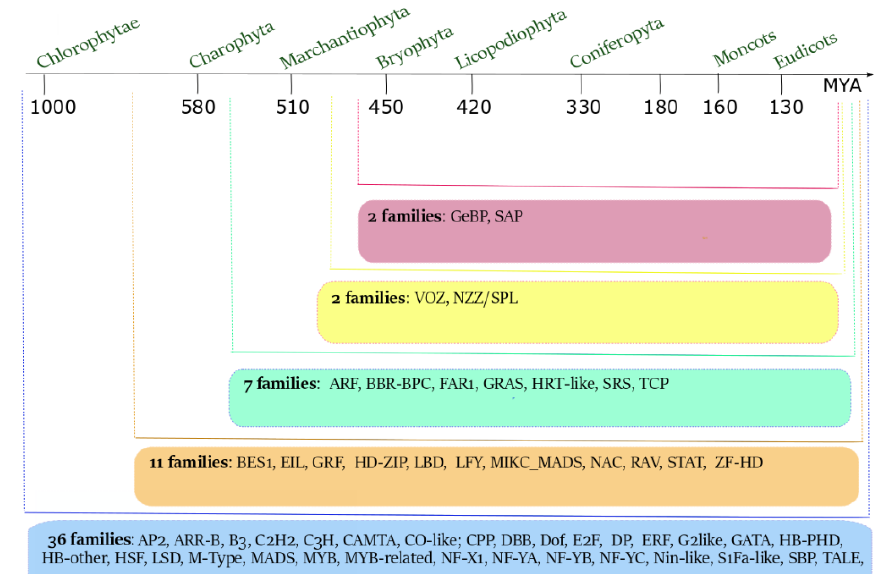
Figure 2. The evolution of the number of transcription factors (TF) families from Chlorophytae to Eudicots. Starting from Chlorophytae, the number of TF families increased in number and type. The number of ancestral TF families present in Chlorophytae was 36. New TF families have originated in Charophyta (11) and in Marchantiophyta (7). The last appearance of new TF families occurred before the origin of Bryophyta, with the recruitment of 4 new families (adapted from